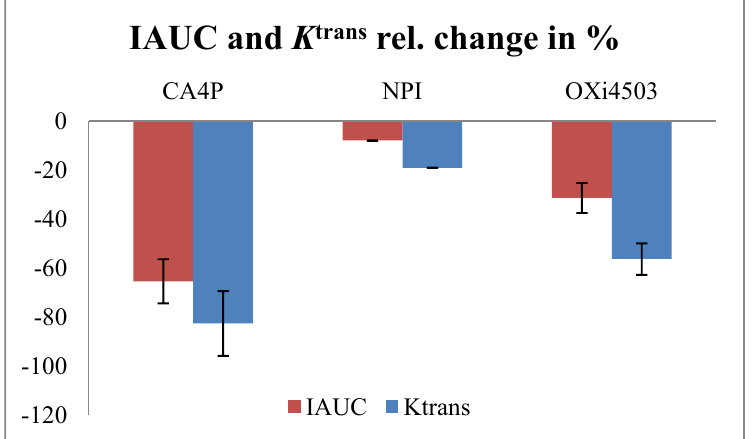
Figure 1. Effect of combretastatin A-4 phosphate (CA4P) (25 mg/kg) [117], NPI (7.5 mg/kg) [132], and combretastatin A-1 Phosphate (OXi4503) (50 mg/kg) (unpublished data) in 200 mm 3 C3H mammary carcinomas as measured by initial area under the curve (IAUC) (90 s) (red) and K trans from Toft’s model (blue) 3 h following treatment. Bars show mean of tumour median values ± SE. IAUC and K trans rel. change in